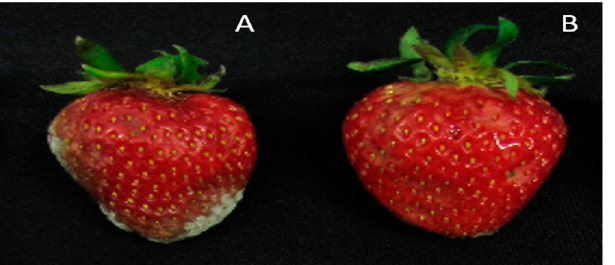
Figure 5. Growth of Botrytis cinerea on strawberry fruits seven days after inoculation. ( A ): control; ( B ): 30% CO 2 treatment.